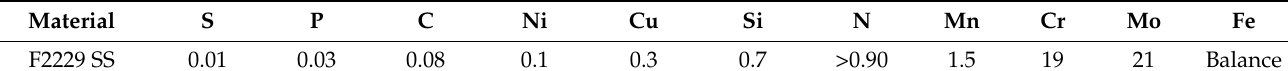
Table 1. Chemical constituents of the substrate material.